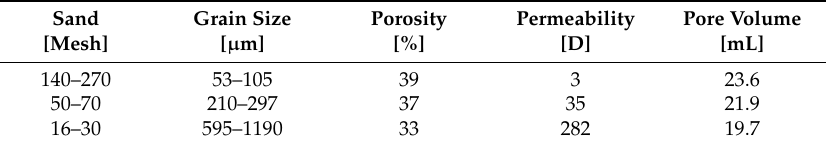
Table 1. Average physical properties of sandpacks.